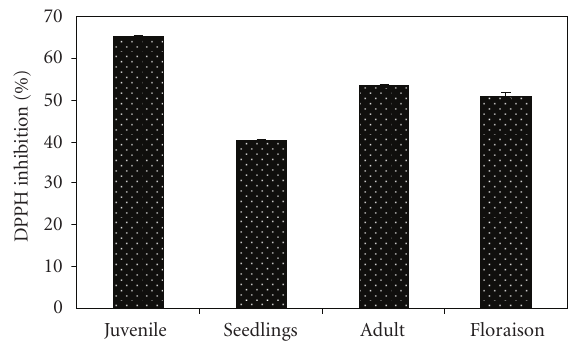
Figure 5: Comparison of antiradical activity in the di ff erent plant extracts by Method 1 extraction.